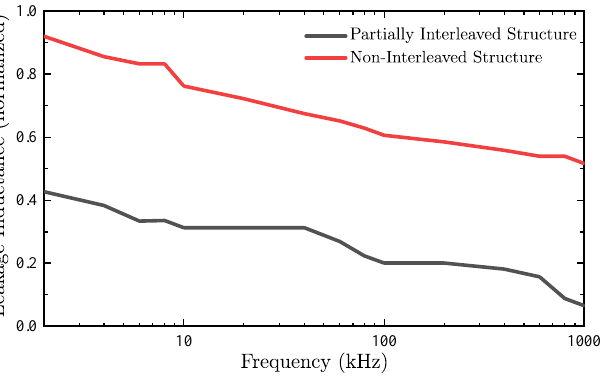
Figure 10. Normalized leakage inductance in partially interleaved and non-interleaved structures. It is visible that leakage inductance was reduced by around 30% for the partially interleaved structure. Reproduced with permission from [51], IEEE,